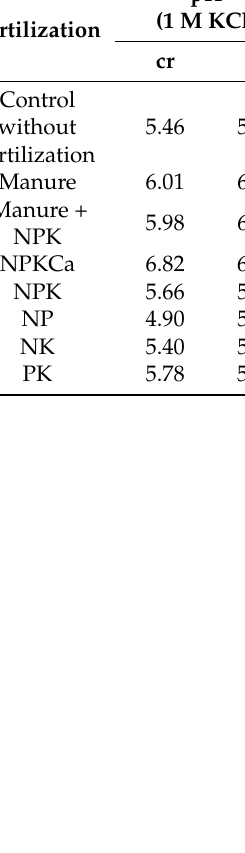
Table 7. Weather conditions during potato vegetation since April to